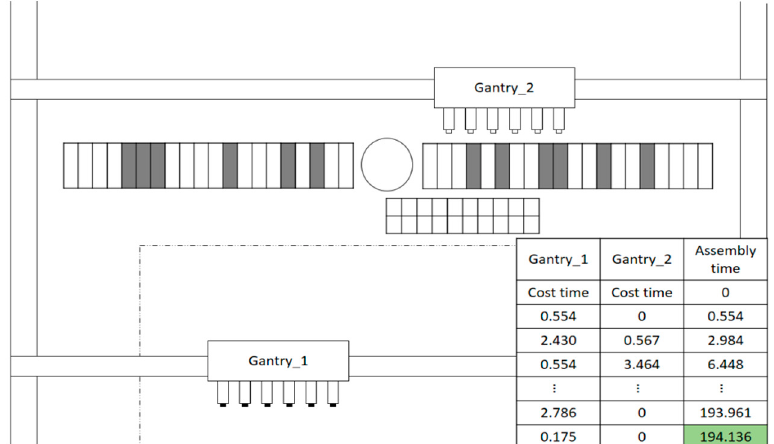
Figure 22. Total assembly time. Table 7. Assembly time for each PCB.